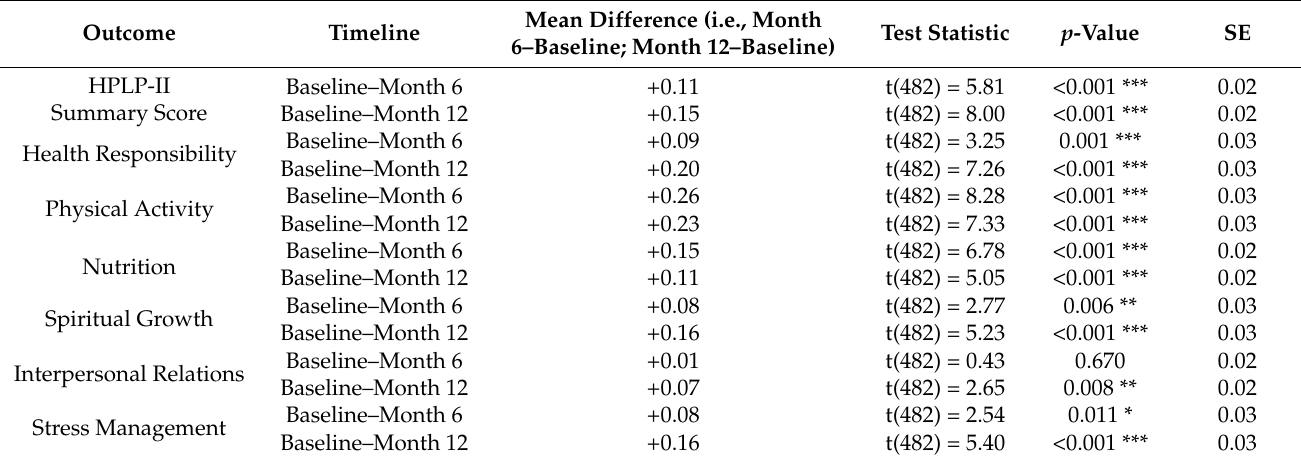
Table 1. Health-Promoting Lifestyle Behaviors (HPLP-II)